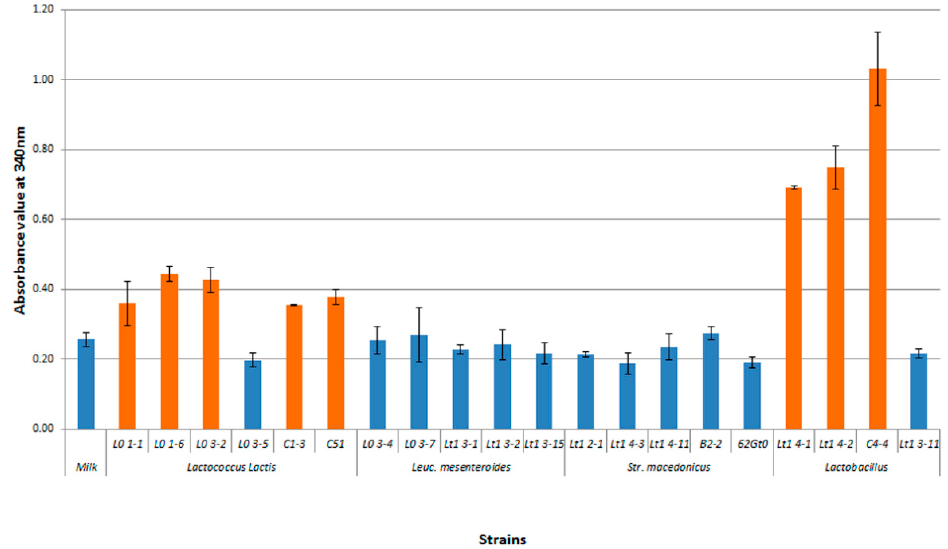
Figure 5. Proteolytic activity of some of the autochthonous lactic acid bacteria tested. Orange bars represent significantly higher proteolytic activity values.